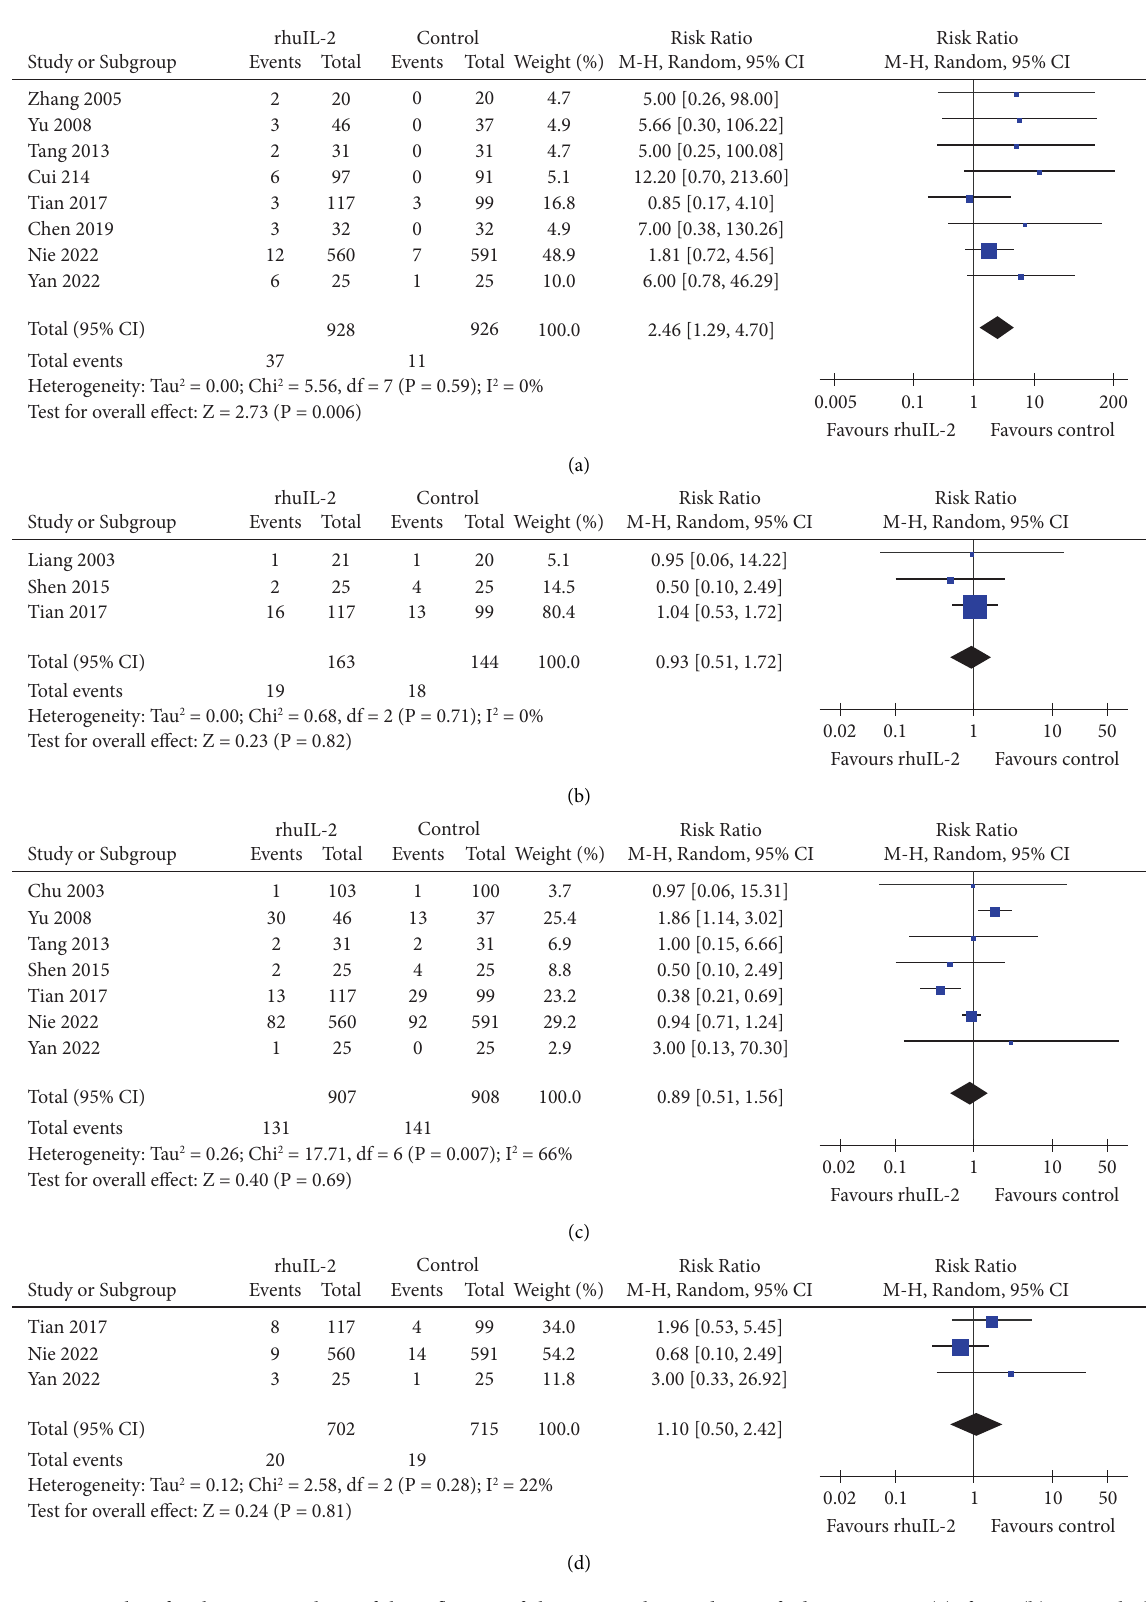
Figure 6: Forest plots for the meta-analysis of the infuence of rhuIL-2 on the incidence of adverse events; (a), fever; (b), musculoskeletal pain; (c), hepatic injury; and (d), renal